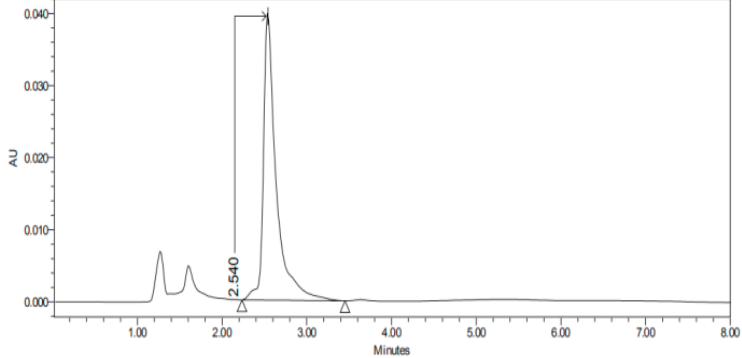
Figure 2. Chromatogram of CP nanoparticles (CP-NPs) in sclera at 6 h.